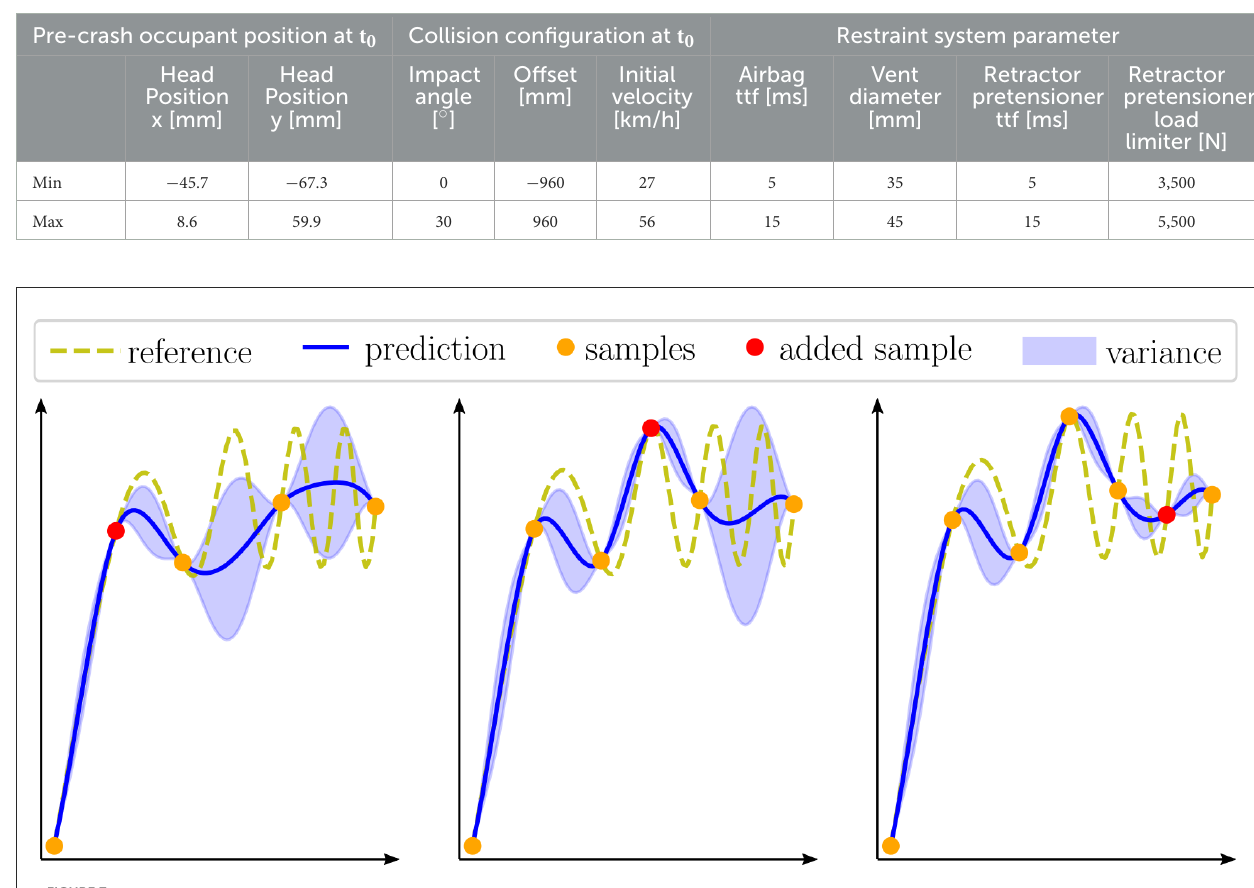
FIGURE7 Visualization of an adaptive sampling process, which determines the next sample based on the maximum